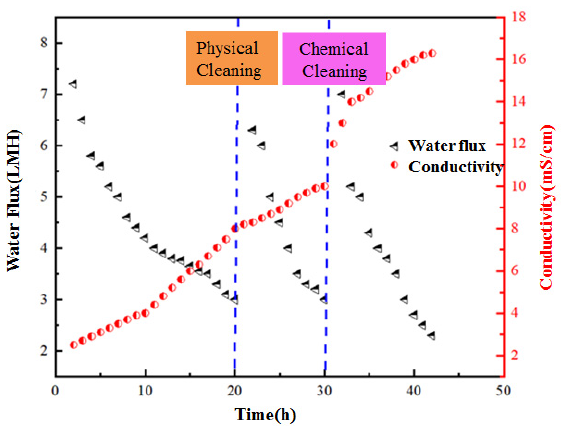
Figure 2. OsMFC water flux and conductivity change with operation time.